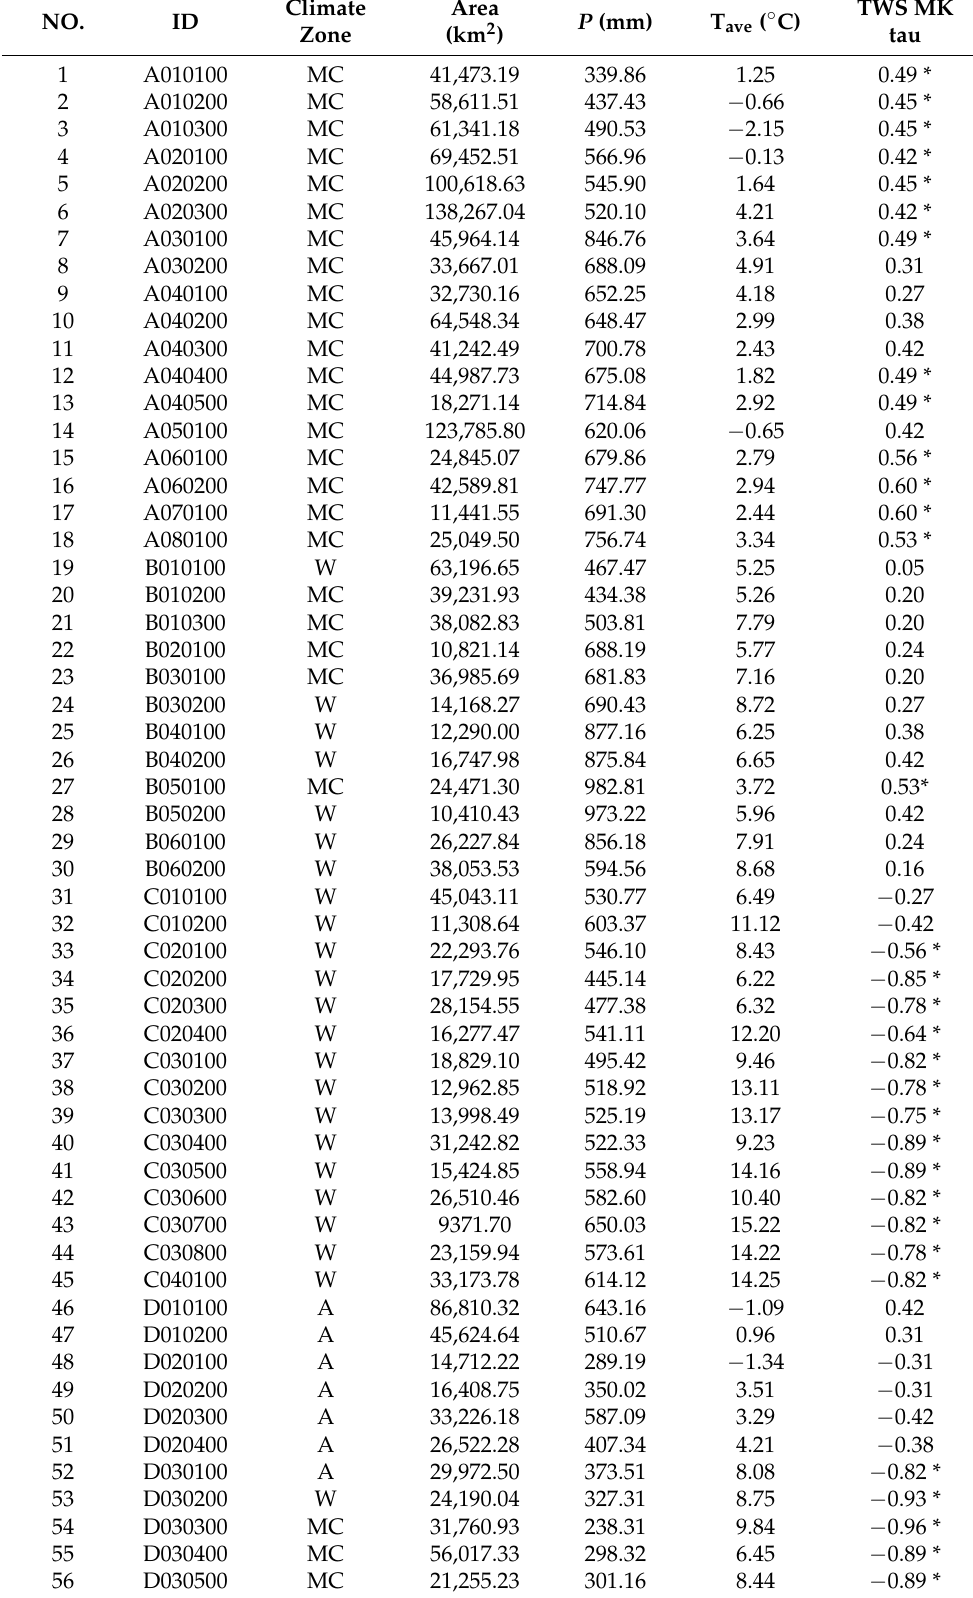
Table A1. Detailed information about watershed size, climate conditions, and TWS tends for 214